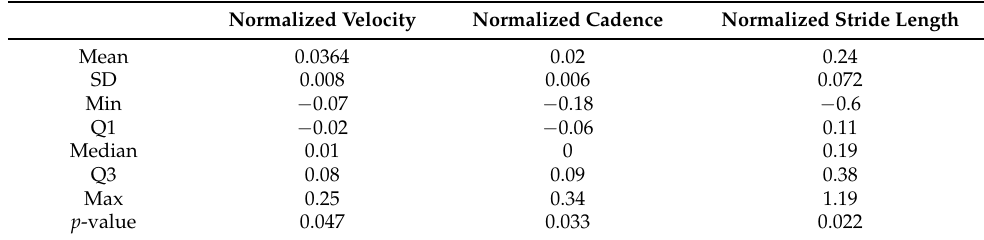
Table 4. The change in parameters’ values reflecting the effect of rehabilitation in the study